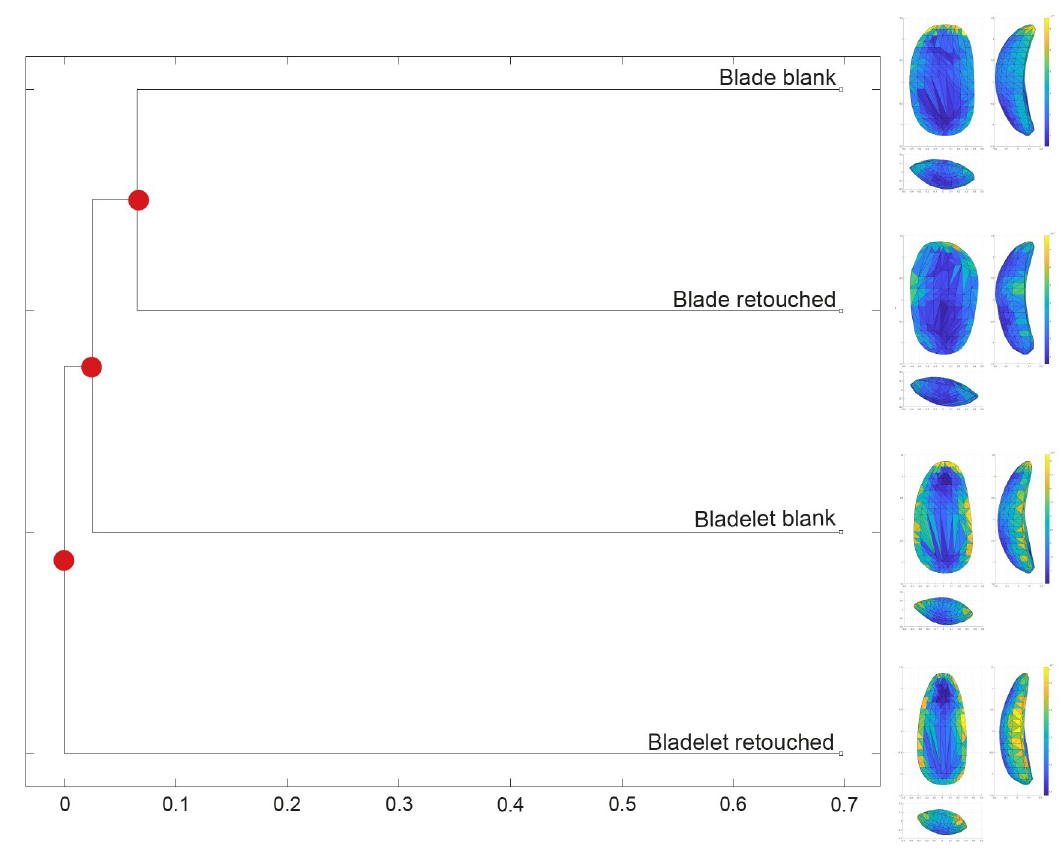
Fig 3. Dendrogram representing the distance between the centroids of all groups analyzed in the first dataset. The mean shapes for each group are also reported. The color coding of the mean shapes represents the spatial distribution of variability within each